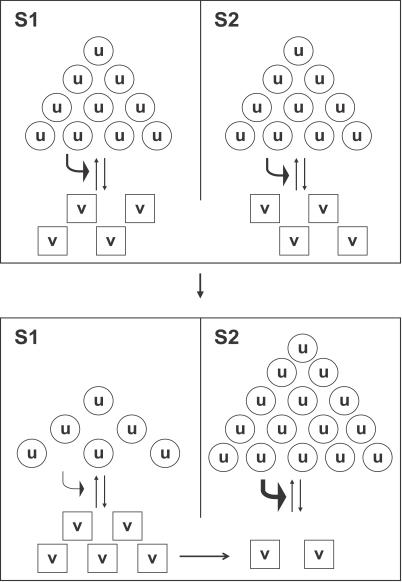
Schematic of Unstable Multiple-Peak Solution in a Mass Conserved Reaction–Diffusion SystemWe set the two-peak solution (S1 and S2, top panel), which is similar to Figure 4C. We consider the following conditions. There are two spaces (each space has one peak). The molecules have two forms, u and v, which have small and large diffusivities, respectively. No molecule is generated or degraded in the spaces. The molecules move between spaces, mainly in v-form, depending on the concentration gradient of v-form molecules. The u-form molecules convert v-form molecules into u-form, and this positive feedback is so strong under the condition where ∂Pe/∂
N̄ < 0 [48] that infusion of molecules into the space causes a decrease in v-form molecules. Infusion of molecules to S2 accompanies the removal of the same number of molecules from S1 because of the mass conservation (bottom panel).